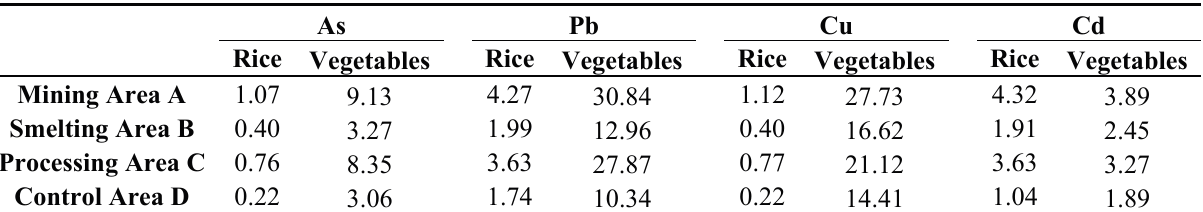
Table 6. Mean heavy metal concentrations in crops from different functional areas (mg/kg d.m.). As Pb Cu Cd Rice Vegetables Rice Vegetables Rice Vegetables